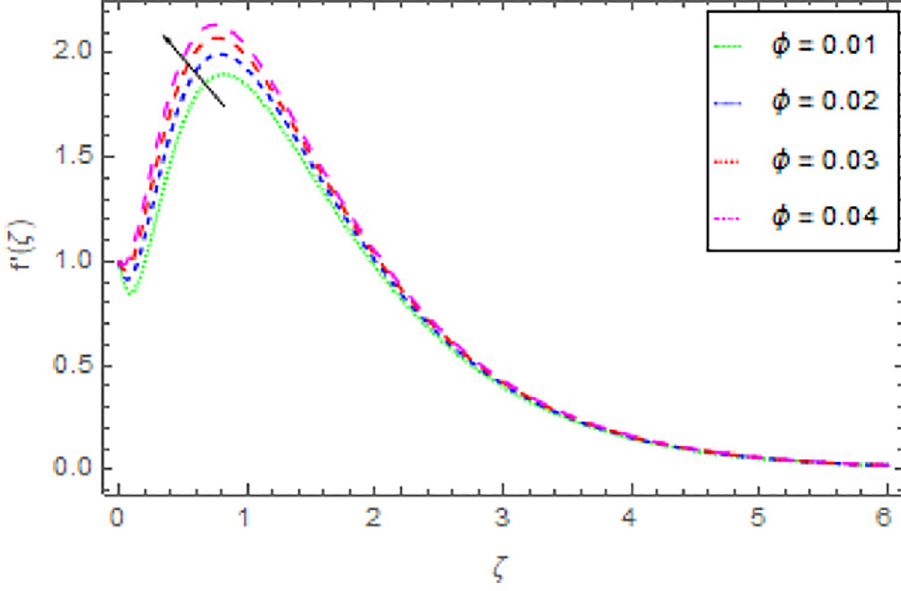
Fig 5. Deviation in nanofluid velocity ( x − direction) against ϕ when Pr = 1000, m = 0.10, n = 1.00, M = 2.50, δ = 0.40, β = 1.00 and Nr = 0.20.